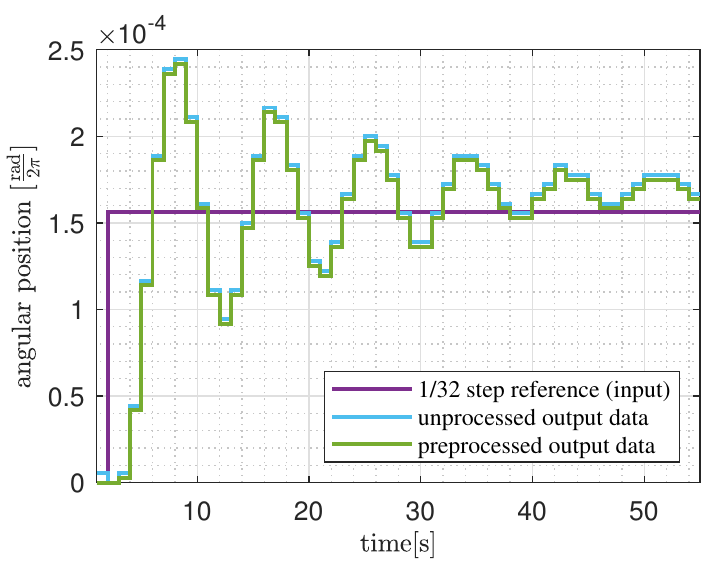
Figure 19. An example of input-output signals used for system identification. Output signal obtained from raw position data by defining steady initial condition and debiasing.